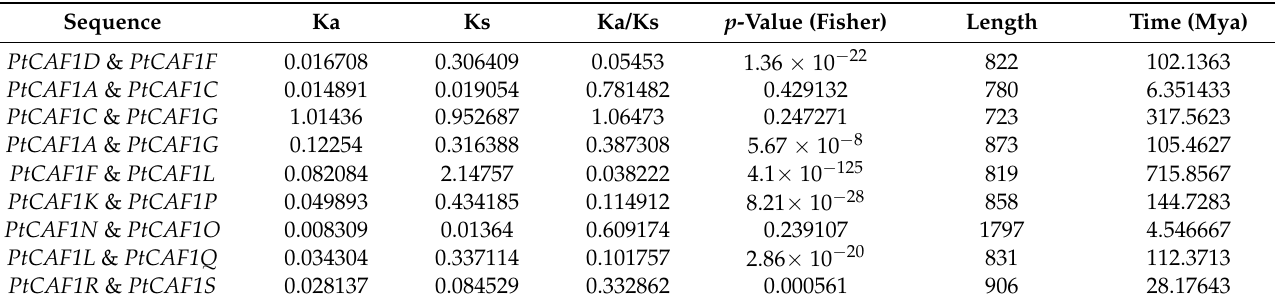
Table 2. Ka/Ks analysis of the PtCAF1 gene pairs